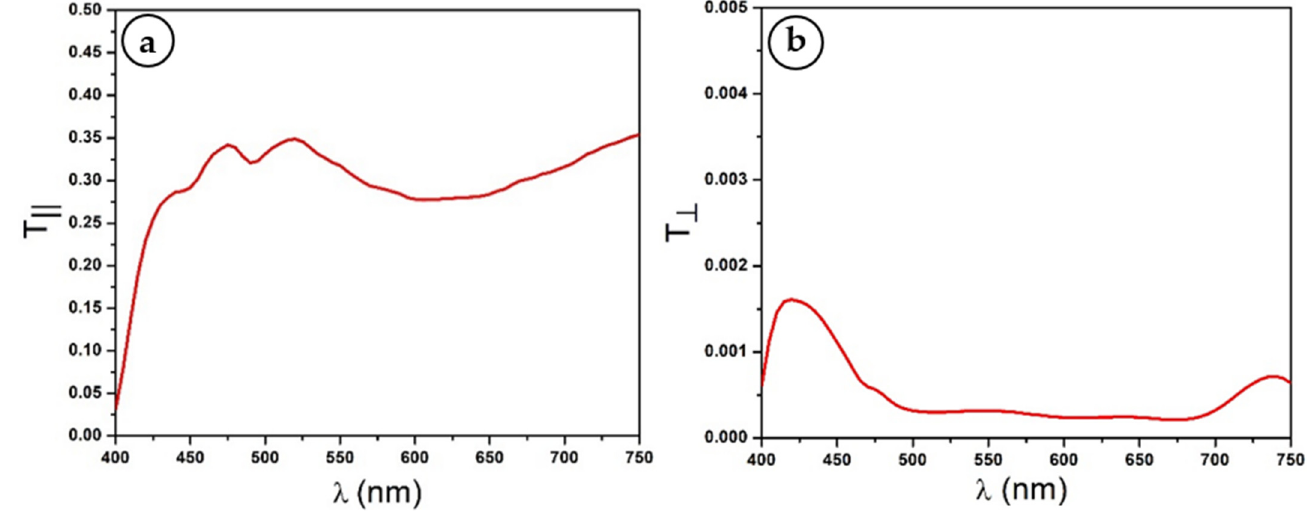
Figure 5. Polarizer and analyzer transmittance spectra for both parallel ( a ) and crossed ( b ) configu- rations.